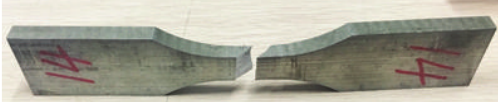
Figure 9: Macroscopic failure modes of the